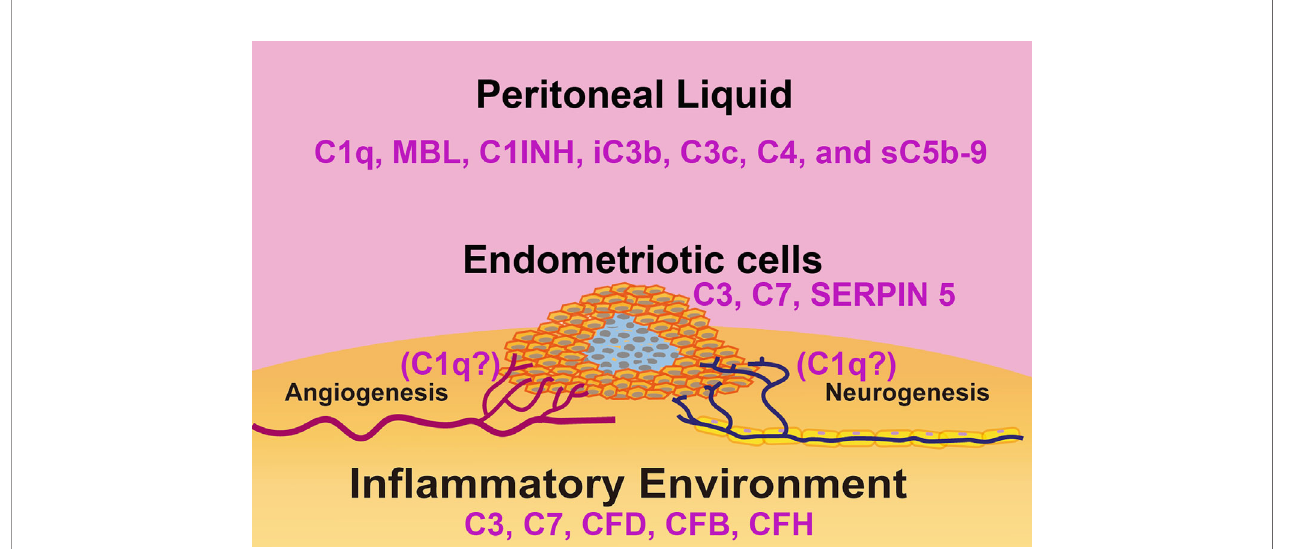
FIGURE 3 | Schematic representation of the complement system in the immune microenvironment of an endometriotic lesion. The lesions consist of epithelial, endothelial, stromal cells and leukocytes present in the tissue and surrounded by peritoneal liquid. Studies have linked disorders of the complement system activity/ expression and pathogenesis of endometriosis. In the endometriotic lesions, high levels of C3, C7, factor D (FD), factor B (FB), and factor H (FH) have been detected. Isolated endometriotic cells express C3, C7 and SERPIN5. In the peritoneal liquid of EM patients, elevated levels of C1q, C4, Mannan-Binding Lectin (MBL), C1 Inhibitor (C1INH), inactivated C3b (iC3b), C3c and soluble C5b-9 (sC5b-9) have been